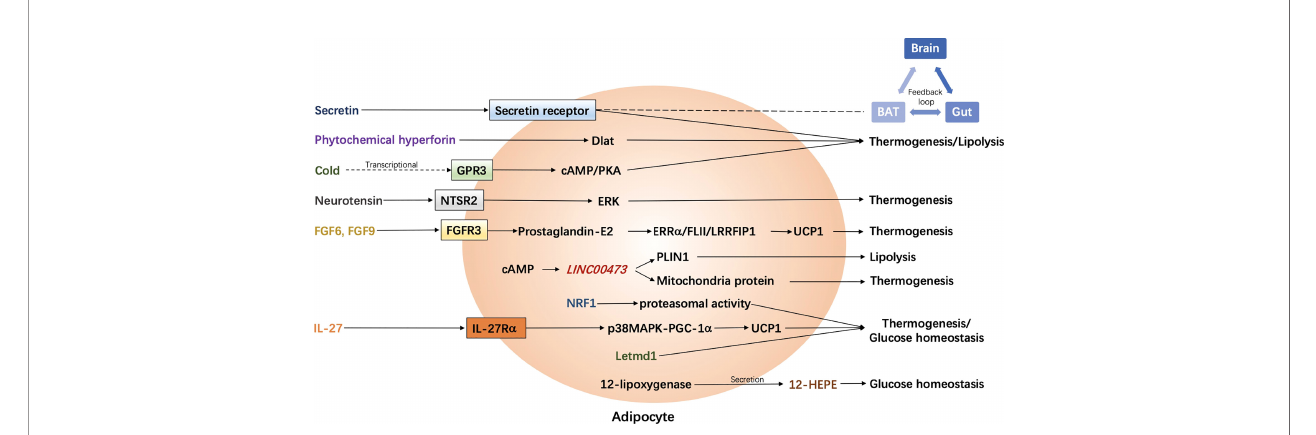
FIGURE 2 | Latest adrenergic receptor-independent signaling pathways in the regulation of human adipocyte thermogenesis. BAT, brown adipose tissue; cAMP, cyclic adenosine monophosphate; Dlat, dihydrolipoamide S-acetyltransferase; ERK, extracellular signal-regulated kinase; ERR a , estrogen receptor-related alpha; FGF, fi broblast growth factor; FGFR3, FGF receptor-3; FLII, fl ightless-1; GPR3, G protein-coupled receptors 3; 12-HEPE, 12-hydroxyeicosapentaenoic acid; IL-27, interleukin-27; IL-27R a , IL-27 Receptor a subunit; Letmd1, Letm1 domain containing 1; LRRFIP1, leucine-rich-repeat-(in FLII)- interacting-protein-1; NRF1, nuclear factor erythroid 2 – like 1; NTSR2, neurotensin receptor 2; p38 MAPK, p38 mitogen-activated protein kinase; PGC-1 a , Peroxisome proliferator-activated receptor gamma coactivator-1 a ; PKA, protein kinase A; PLIN1, Perilipin 1; UCP1, uncoupling protein